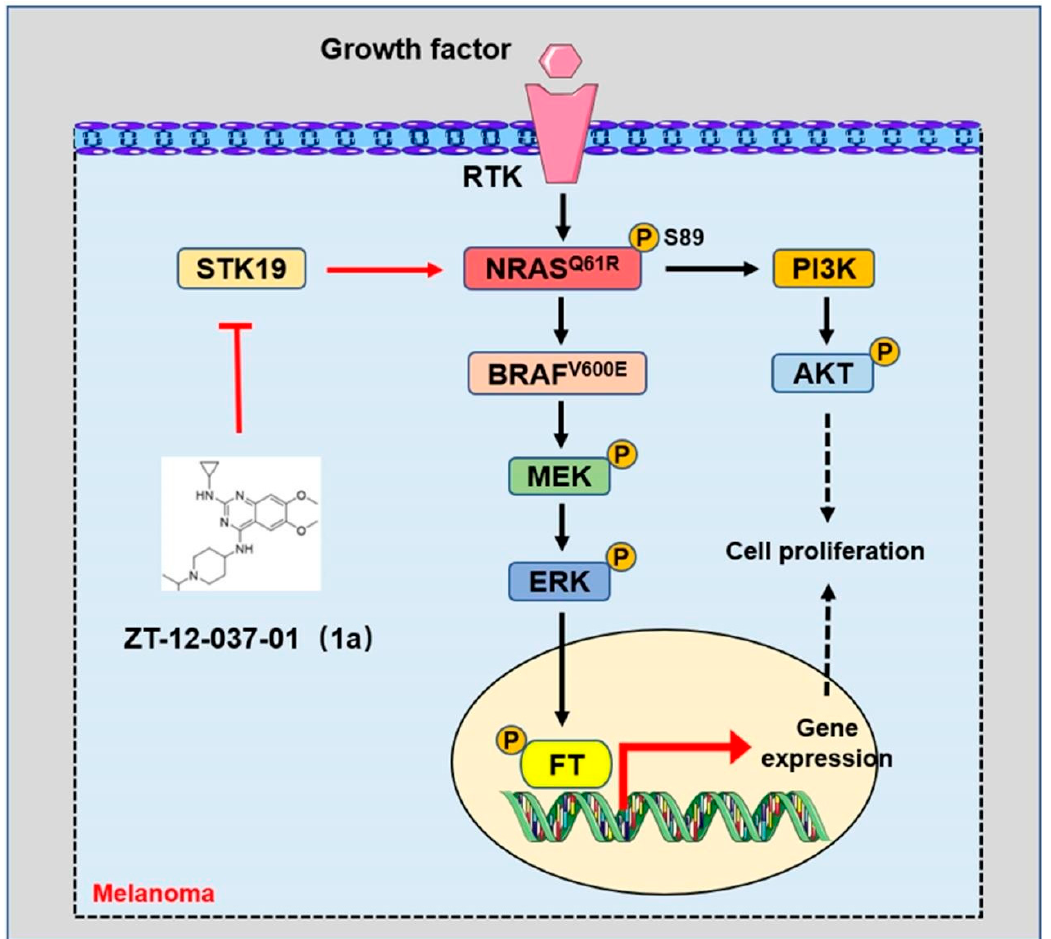
Figure 5. Targeted inhibition of STK19 inhibits oncogenic NRAS-driven melanomagenesis. In melanoma, STK19 phosphorylates NRAS at the serine 89 site to increase the activation of NRAS-regulated signaling pathways. ZT-12-037-01 (1a) is a specific STK19-targeted inhibitor, which blocks the malignant transformation of melanocytes and melanoma growth driven by carcinogenic NRAS by inhibiting